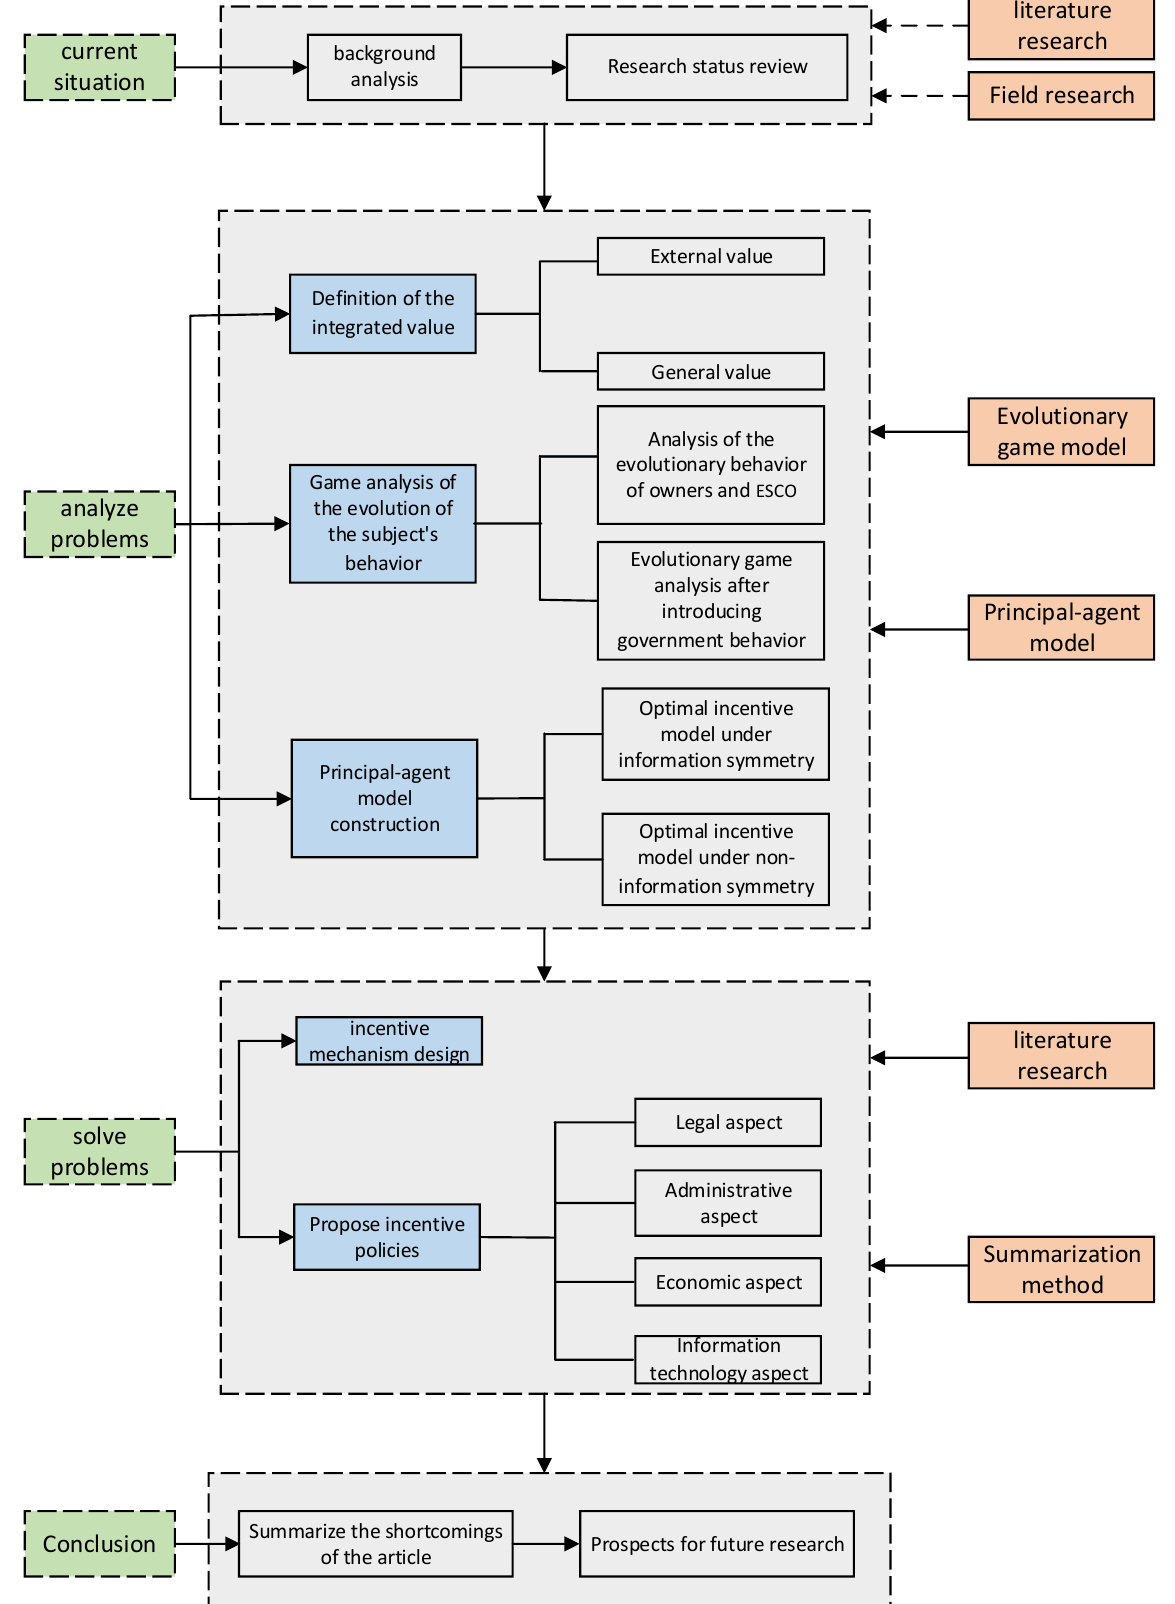
Figure 1. Technology roadmap.